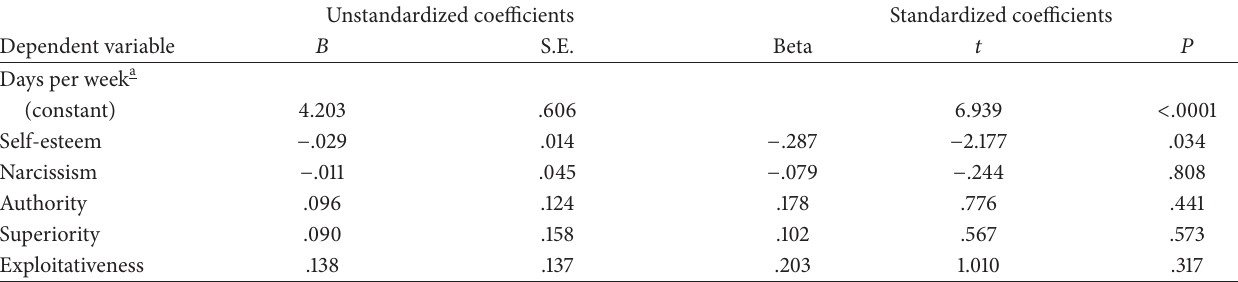
Table 3: Linear regression